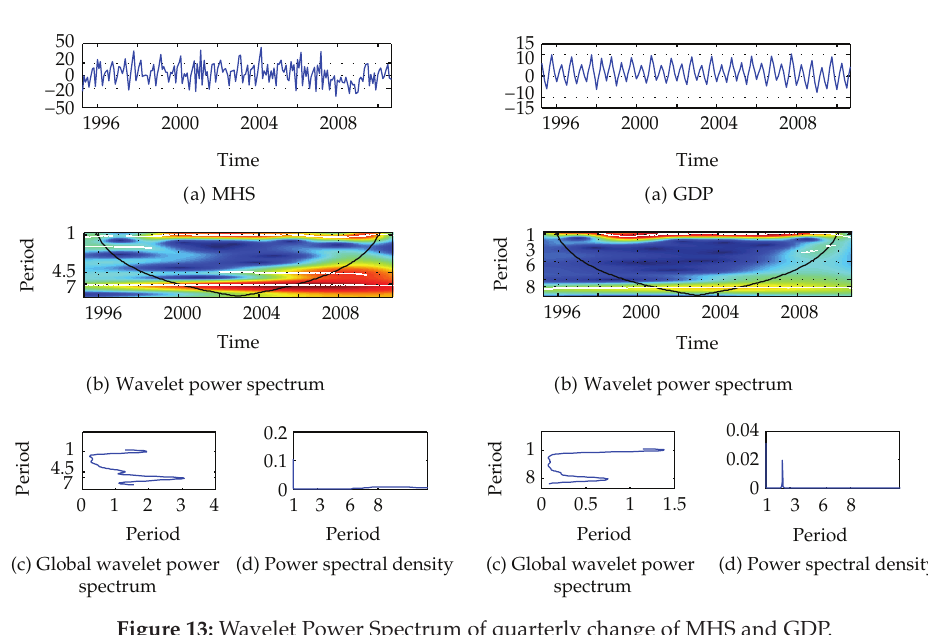
Figure 13: Wavelet Power Spectrum of quarterly change of MHS and GDP.